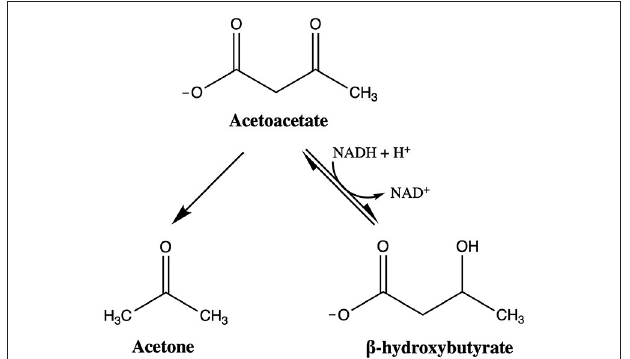
FIGURE 3 | Interconversion and structure of ketone bodies. If acetoacetate is not oxidized to acetyl-CoA to enter the tricarboxylic acid (TCA) cycle, acetoacetate can convert to acetone or β -hydroxybutyrate. Acetoacetate decarboxylase catalyzes the reaction of acetoacetate to acetone, which is exhaled or excreted as waste. The interconversion of acetoacetate and β -hydroxybutyrate is catalyzed by β -hydroxybutyrate dehydrogenase, with the extent of the reaction dependent upon the cellular pool of NAD + . If the reaction favors acetoacetate, acetoacetate is oxidized to acetyl-CoA and enters the TCA cycle to generate